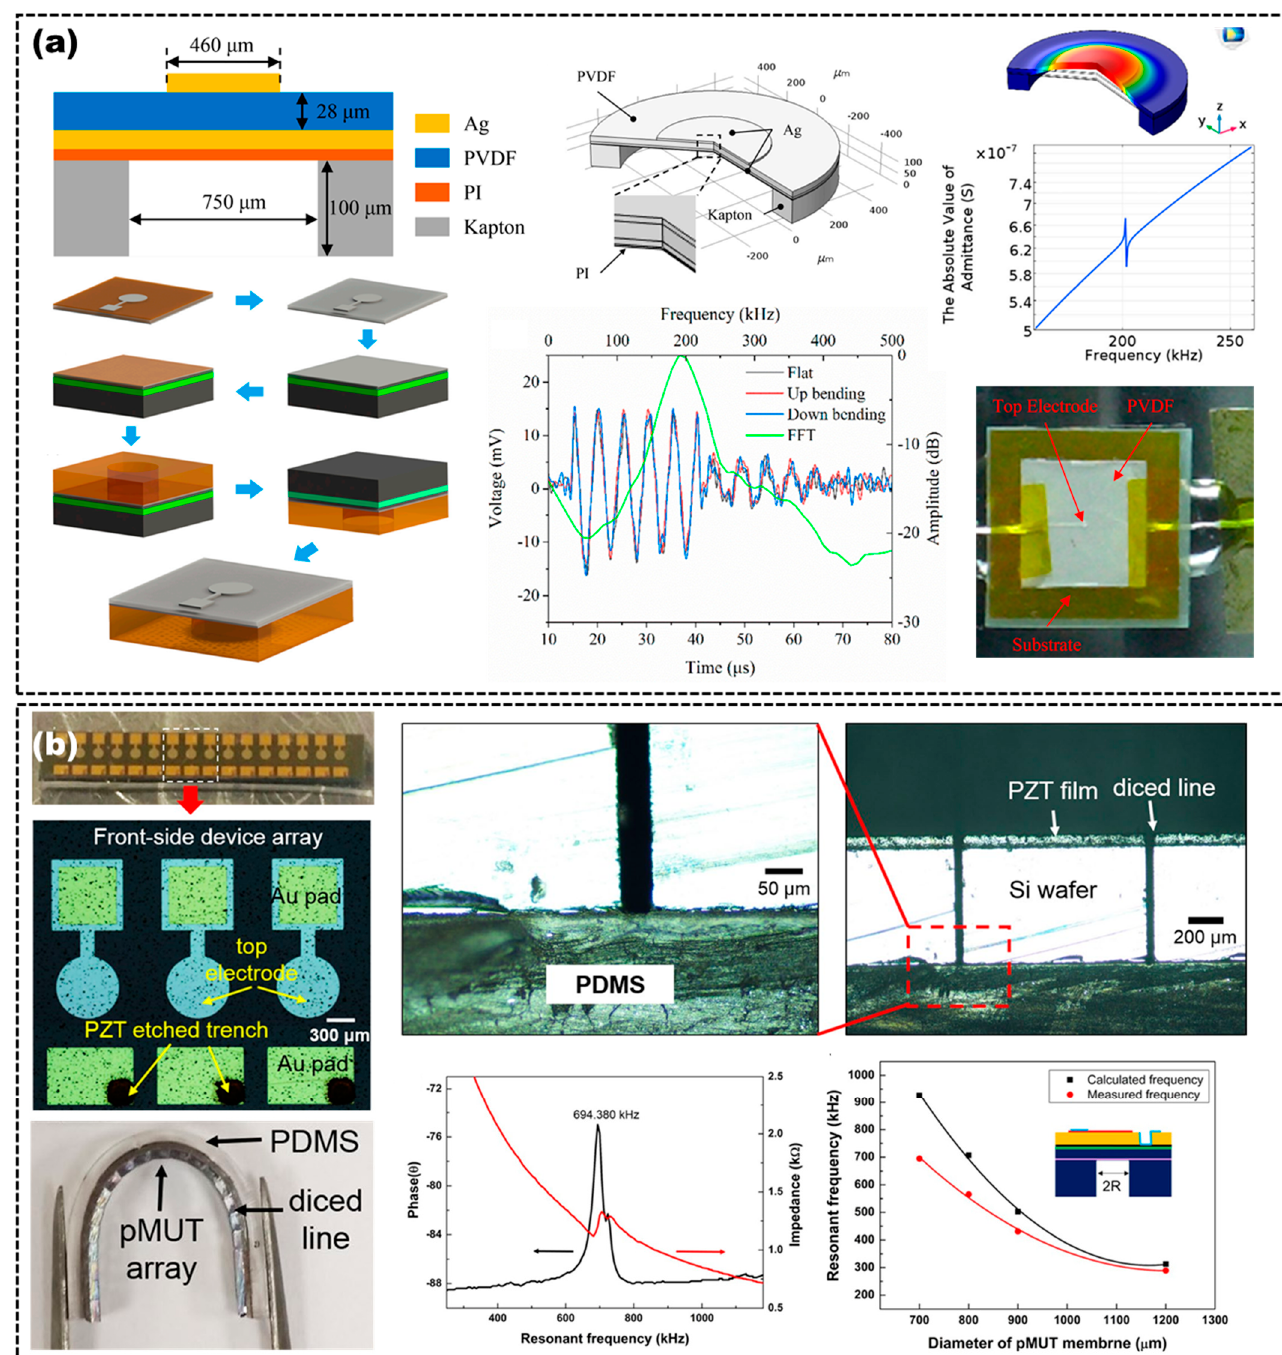
Figure 7. ( a ) Cross ‐ sectional view of a PMUT unit ( top left ), finite element analysis of the PMUT ( top right ), schematic illustration of the fabrication process ( bottom left ), spectrum of the receiving signals ( middle bottom ) and optical image of the PMUT ( bottom right ). Adapted from [29]. ( b ) Optical image of a PMUT array ( left ), cross ‐ sectional microscopy image of a PMUT array on PDMS after the dicing process (top right), phase and impedance results of a PMUT ( middle bottom ) and resonant frequencies of the PMUT with different membrane diameters ( bottom right ). Adapted from [62].